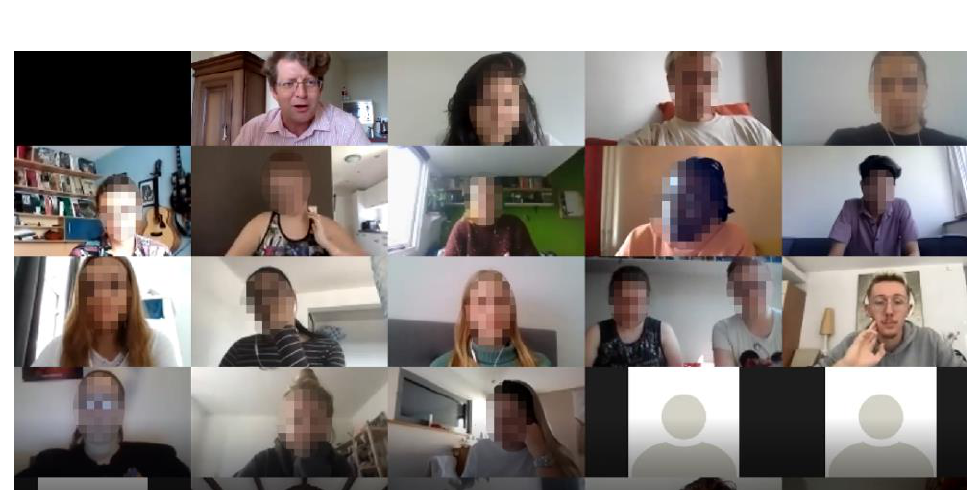
Figure 1. Visual representation of participant behaviors